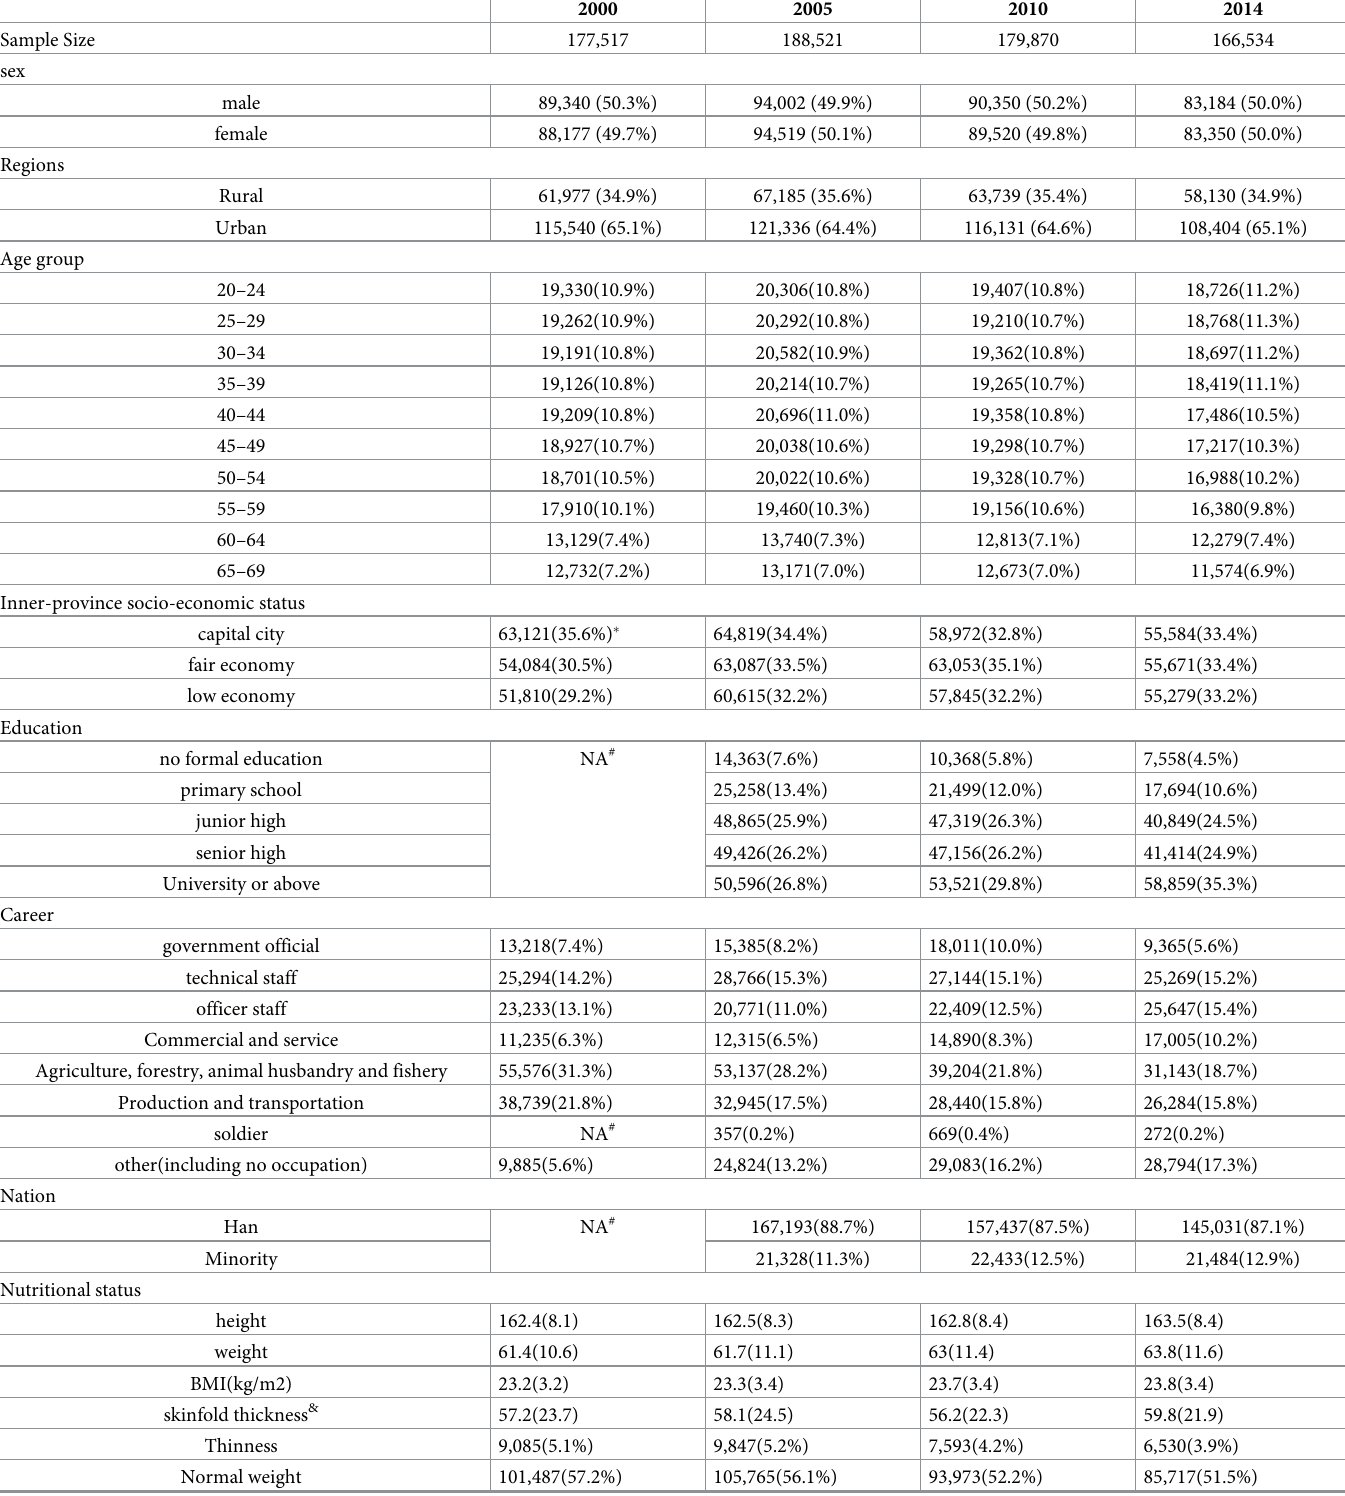
Table 1. The general characteristic and handgrip strength levels of the study population in each of the four national surveys from 2000 to